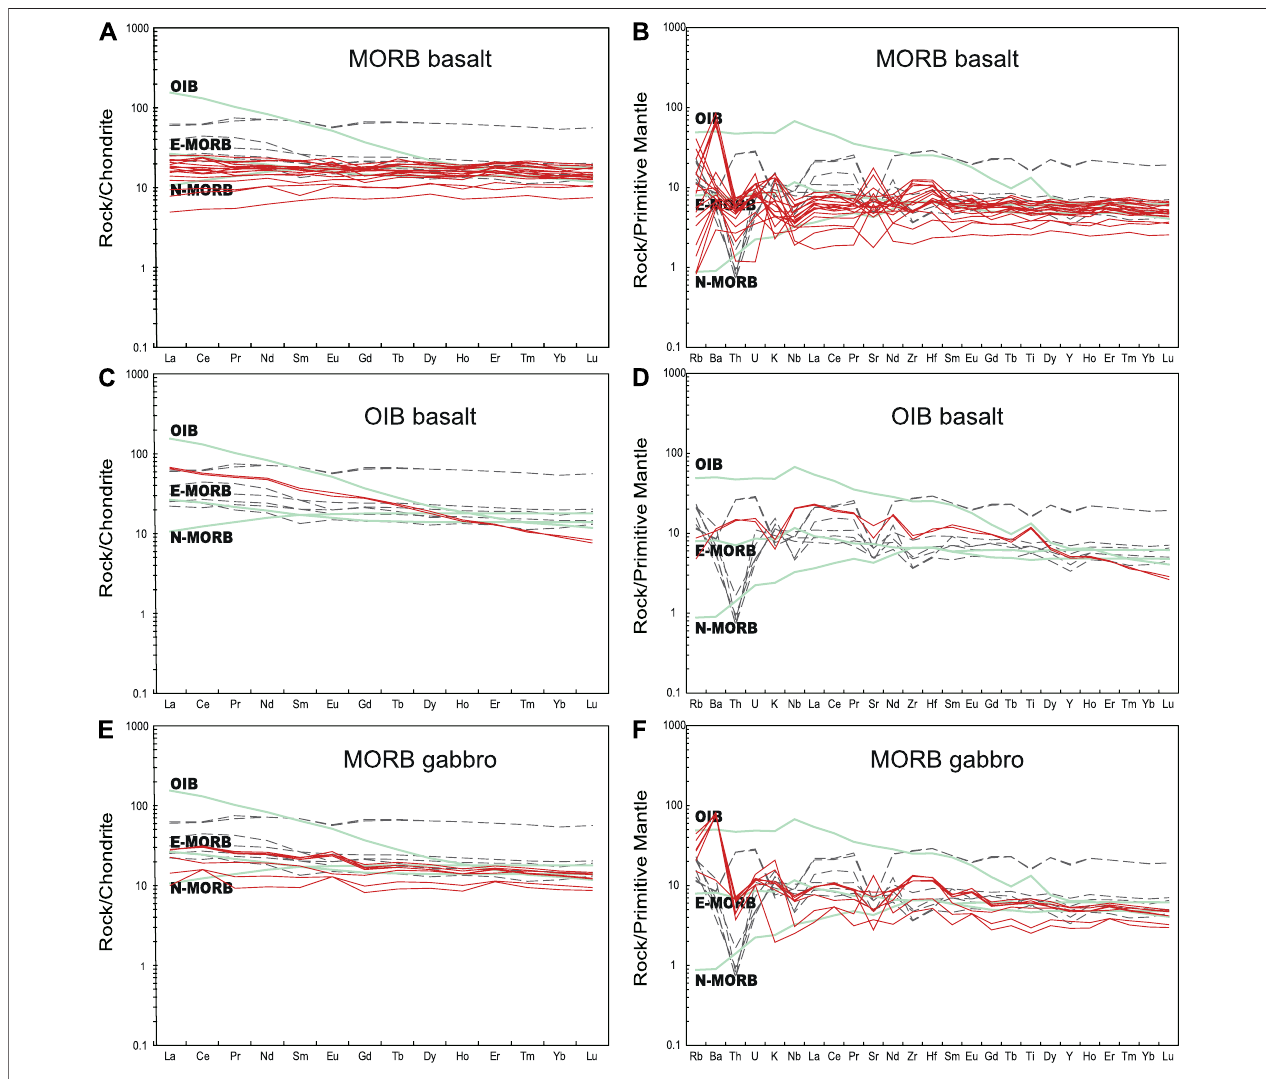
FIGURE9| Chondrite-normalized REEpatternsandPrimitiveMantle (PM) – normalized multi-elementdiagramsforthegabbrosfromtheHuaniushancomplex.The chondrite values are given by Boynton, (1984). The PM, N-MORB, E-MORB, and OIB values are given by Sun and McDonough, (1989). Data of dash lines for the Gubaoquan eclogite are given by Qu et al.,